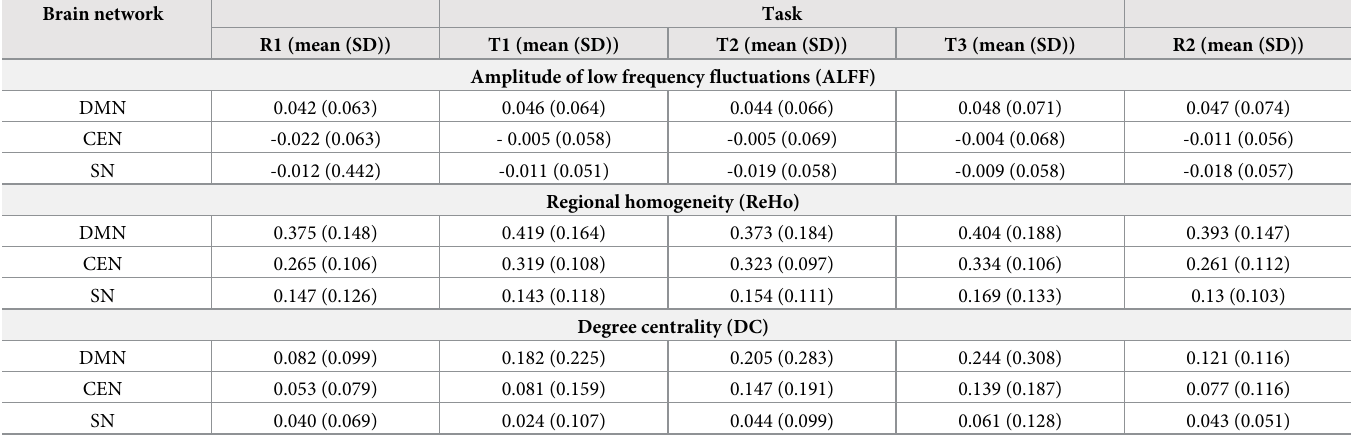
Table 2. Mean values and standard deviations (SD) of the three fMRI measures during the two RS periods (R1 and R1) and the three subtasks of the VOP (T1, T2 and T3) obtained from the triple network (default mode network (DMN), salience network (SN), and central executive network (CEN)), based on the mean values of each parameter in 21